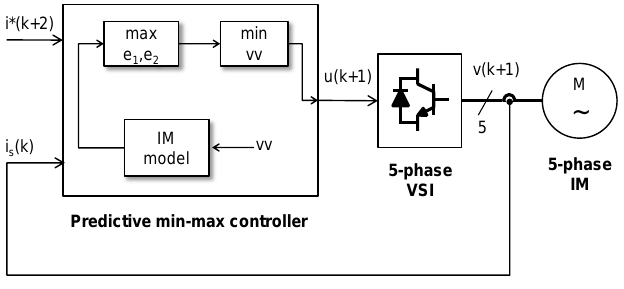
Figure 1. Block diagram of min-max Predictive Stator Current Control (PSCC) for a five-phase induction machine (IM) driven by an Voltage Source Inverter